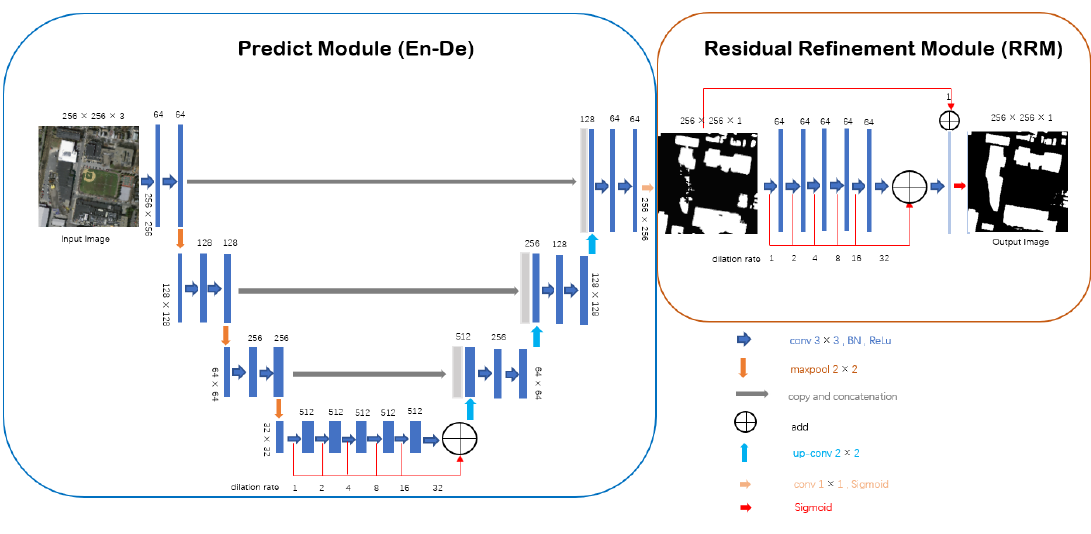
Figure 2. The structure of Building Residual Refine Network (BRRNet). BRRNet consists of two parts: the prediction module and the residual refinement module. The prediction module is based on an encoder–decoder structure, which gradually increases the receptive field during feature extraction by introducing atrous convolution with different dilation rate to extract more global features. The prediction module finally outputs the preliminary building extraction results of the input image. The residual refinement module takes the output of the prediction module as an input. By correcting the residual between the result of the prediction module and the real result, it finally further improves the accuracy of building